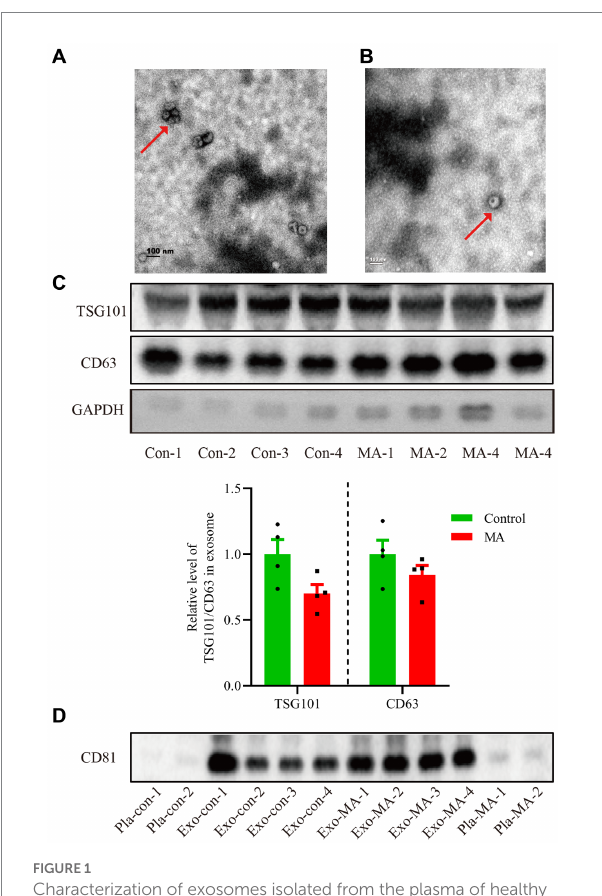
FIGURE 1 Characterization of exosomes isolated from the plasma of healthy controls and MA patients by ultracentrifugation. (A) Exosomes isolated from healthy controls detected by transmission electron microscopy. Scale bars: 100 nm. (B) Exosomes isolated from MA participants visualized by transmission electron microscopy. Scale bars: 100 nm. (C) Total proteins from the isolated exosomes were subjected to Western blotting analysis to confirm the presence of exosomes, using anti-CD63 and TSG101 antibodies. Histogram panel: the relative level of TSG101/CD63 protein over GAPDH. Data are expressed as mean ± SEM, n = 4 per group. (D) Total proteins from the plasma or exosome were used to perform Western blot analysis to verify the presence of exosomes, using anti-CD81 antibodies. Con, control; MA, methamphetamine; Pla, plasma; Exo,